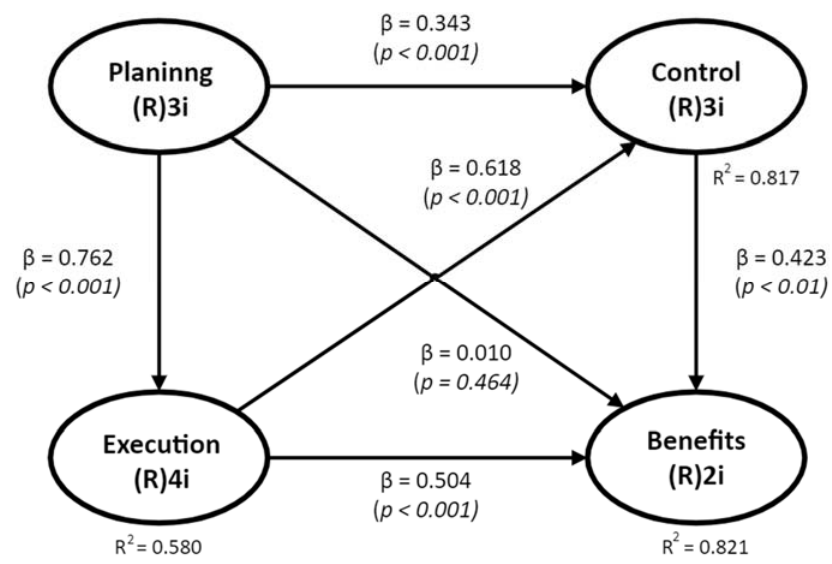
Figure 2. Structural equation model.